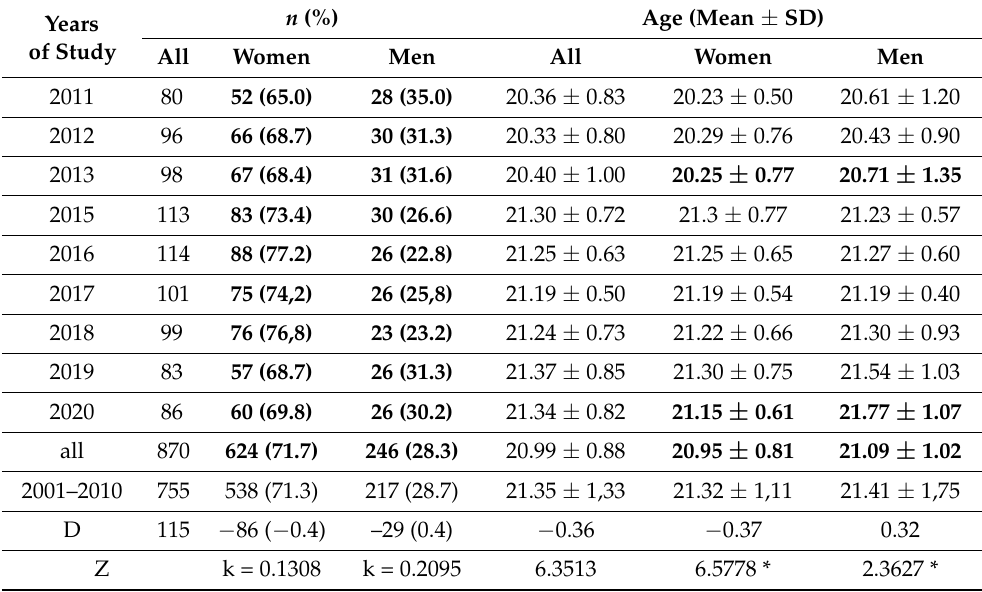
Table 1. Demographic characteristics in/of